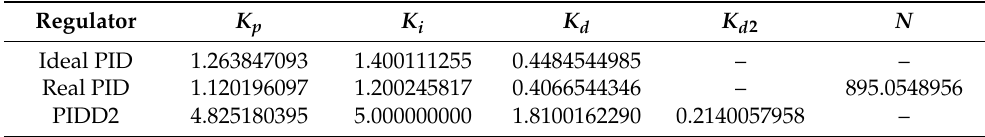
Figure 6. Generator voltage responses of the three regulators. Table 2. Optimal values of the parameters determined using the SA–GTO algorithm proposed.